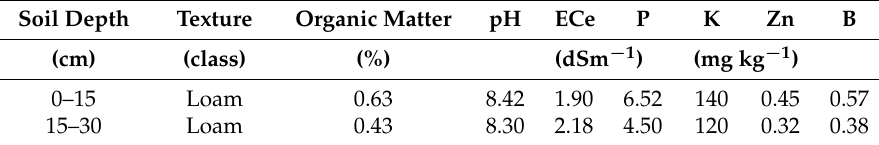
Table 1. Soil physicochemical characteristics and mineral nutrient status of the study orchard